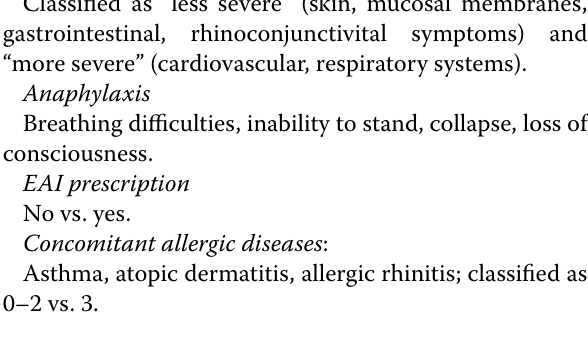
Table 1 Linear regression analyses for children with specialist-diagnosed food allergy, by age group (n